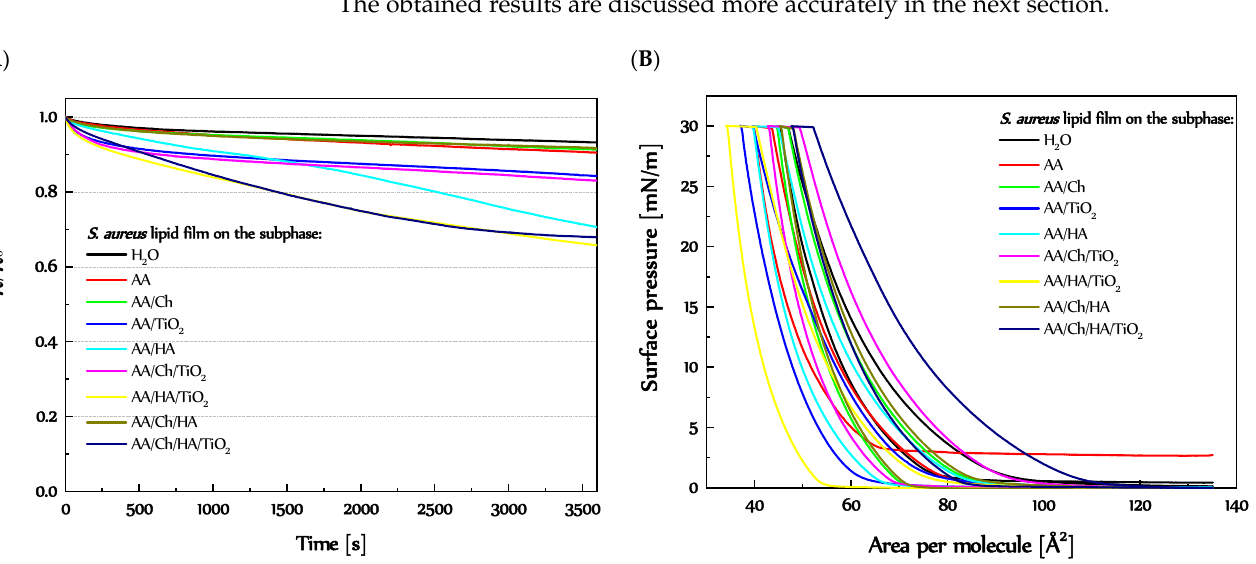
Figure 5. ( A ) π / π 0 = f(t) and ( B ) hysteresis loops (more details Figures S3 and S4) obtained by compression and decompression of the S. aureus lipid monolayers on the individual subphases. The magnitude of the hysteresis loops obtained during compression-decompression measurements provides information about the existence of interactions between lipids molecules (in a closely packed layer) and subphase components, as a result of which the loss of material from interface could have occurred. Both compression and decompression curves for S. aureus lipid film had similar courses on each of the subphases (except AA) (Figure 5). In all cases, the descending curves were shifted to smaller molecular areas, besides reference. In effect, hysteresis loops of considerable sizes were obtained (Figures S3 and S4).